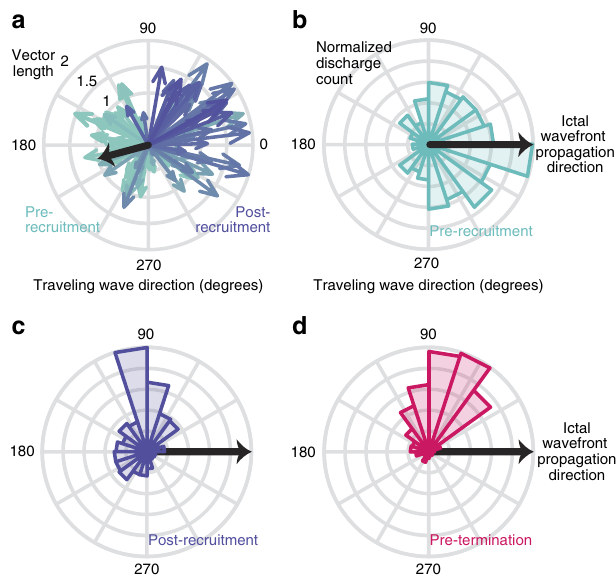
Figure 3 | Travelling wave directions during seizure epochs are dependent on the location of the ictal wavefront. ( a ) Example velocity vectors for one seizure before and after recruitment. The black line indicates the direction of ictal wavefront passage across the MEA. The shift in direction between pre-recruitment and post-recruitment discharges that occurs precisely at the time of ictal wavefront passage is apparent. In each case, the ictal wavefront’s location relative to the MEA site is opposite to the predominant travelling wave direction. ( b – d ) Distributions of travelling wave directions across all seizures, relative to the direction of the ictal wavefront (black line), coloured by epoch ( b : pre-recruitment, c : post- recruitment, d :